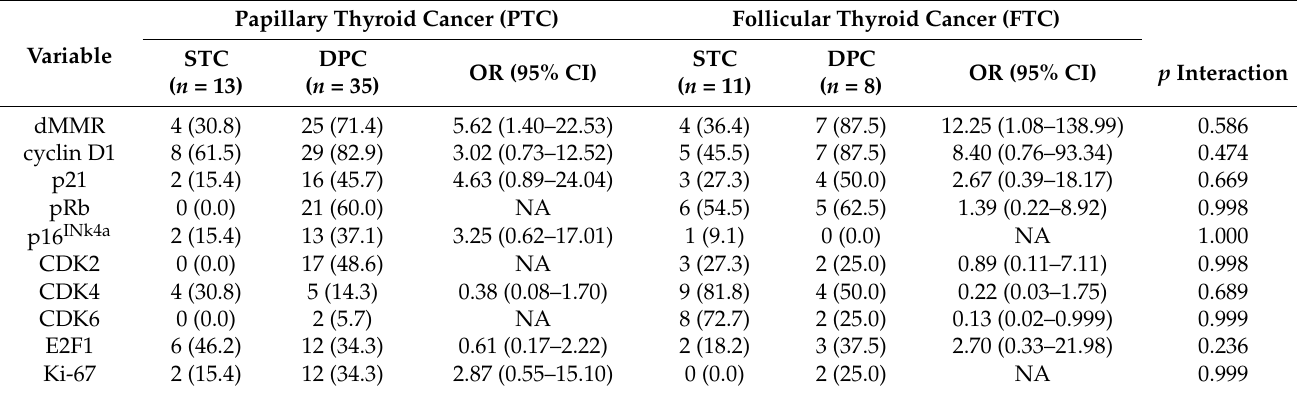
Table 3. The association between the biomarker and the status of STC/DPC stratified by thyroid tumor subtype.